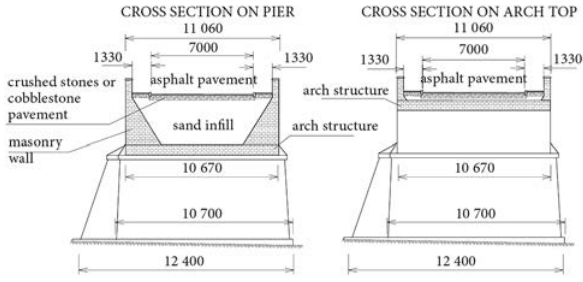
Fig. 3. Characteristics of the cross sections on the pier and on arch top before